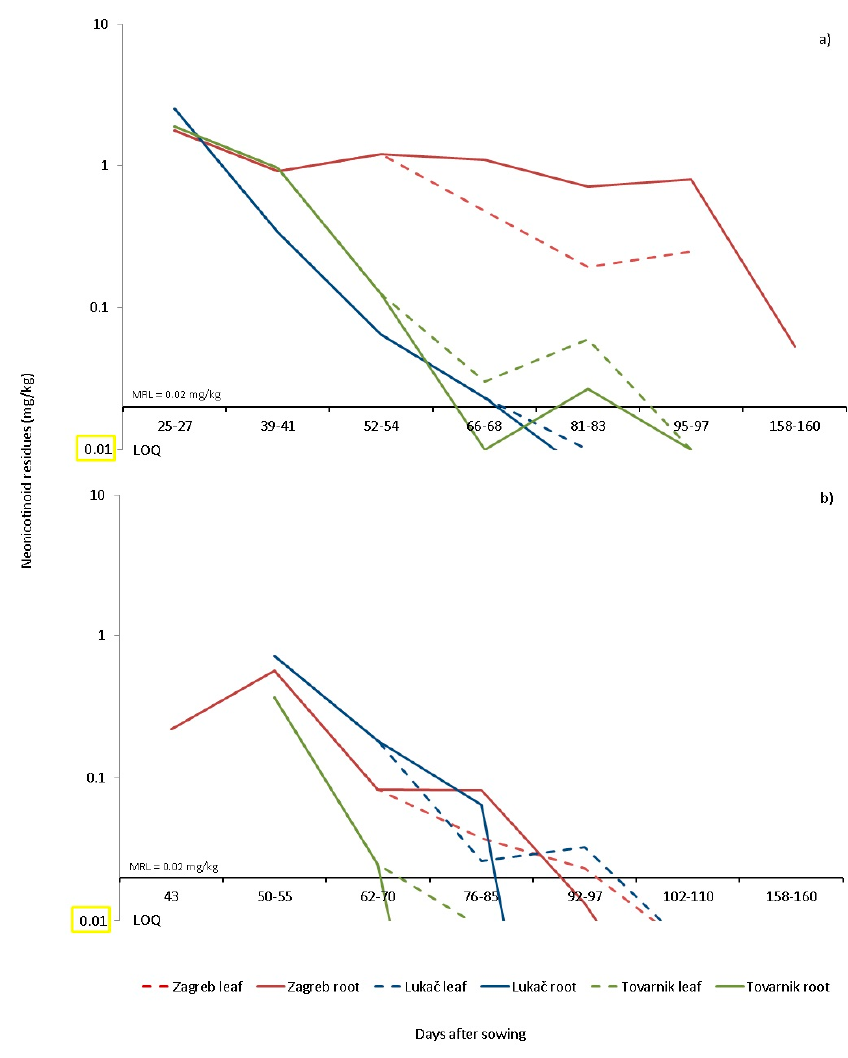
Figure 2. Degradation dynamics of thiamethoxam (expressed as sum of thiamethoxam and clothianidin) during the growing seasons 2015 ( a ) and 2016 ( b ) in sugar beet plants in Lukac, Tovarnik and in greenhouse trials, in compliance with the maximum permitted residue level of 0.02 mg / kg; LOQ— limit of quantification; MRL—maximum residue level. Table 8. Thiamethoxam (including chlothianidin) residues in the whole plants during the first three observing periods and for roots at harvesting in